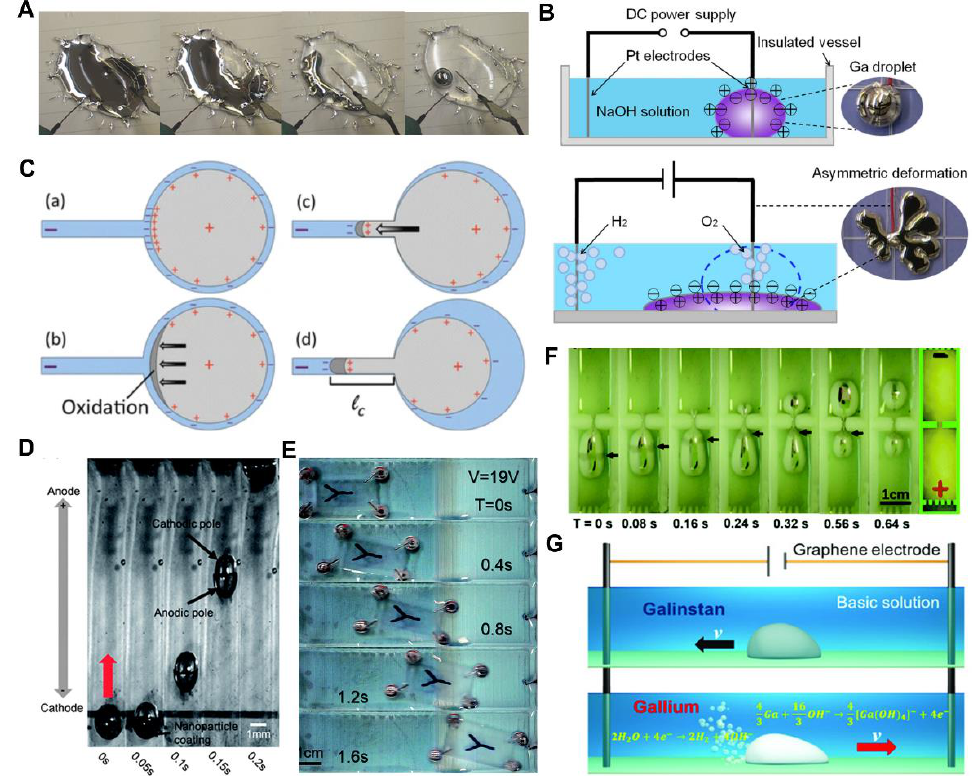
Figure 8. Electrically induced responses. ( A ) The electrically induced transformation of liquid metal (LM) droplet from a film into a sphere. Reprinted with permission from ref. [127]. Copyright 2014, John Wiley and son. ( B ) Schematic of the large scale deformation of the LM droplet. Reprinted from Ref. [70]. ( C ) The electrochemical actuation process of LM droplets. Reprinted from Ref. [128]. ( D ) Sequential snapshots for LM marbles moving in basic solution. Reprinted with permission from ref. [131]. Copyright 2013, The Royal Society of Chemistry. ( E ) Continuous captures of vehicle locomotion under electric field. Reprinted with permission from ref. [136]. Copyright 2016, The Royal Society of Chemistry. ( F ) Continuous captures of a LM droplet passing through a slit. Reprinted with permission from ref. [137]. Copyright 2016, The Royal Society of Chemistry. ( G ) Schematic diagram of the autonomous motion of the LM droplets with component of GaInSn and gallium, respectively. Reprinted from Ref. [138].